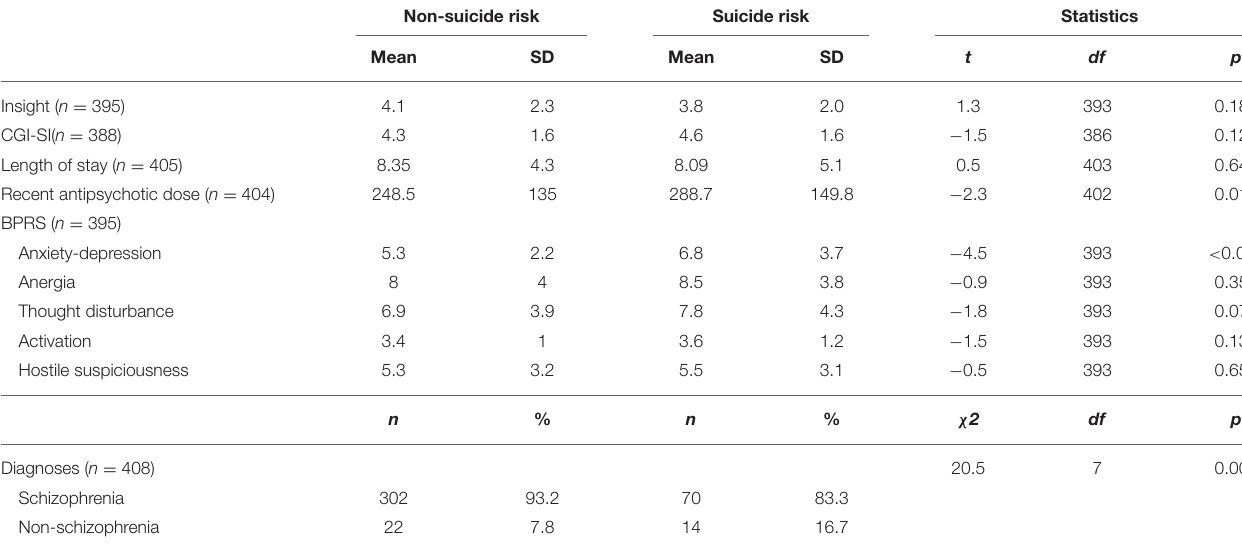
TABLE 2 | Clinical characteristics of the sample.